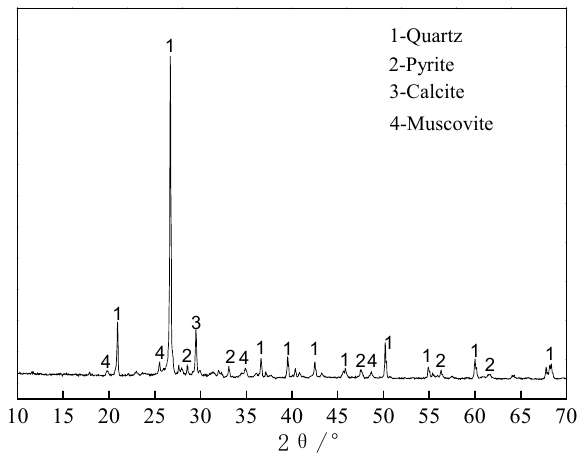
Figure 1. XRD image of stone coal ore.